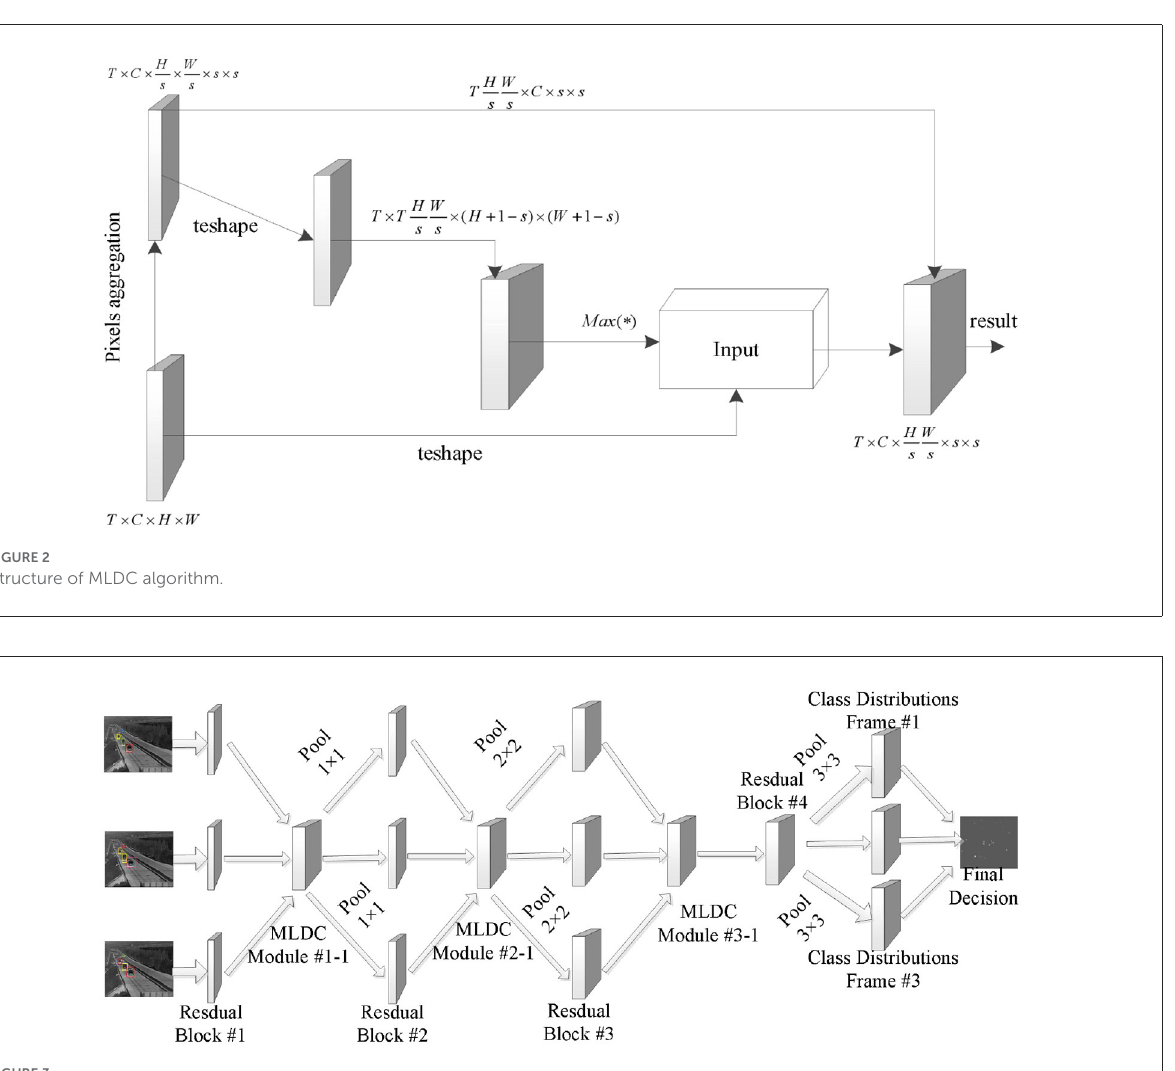
FIGURE3 Overall framework of the